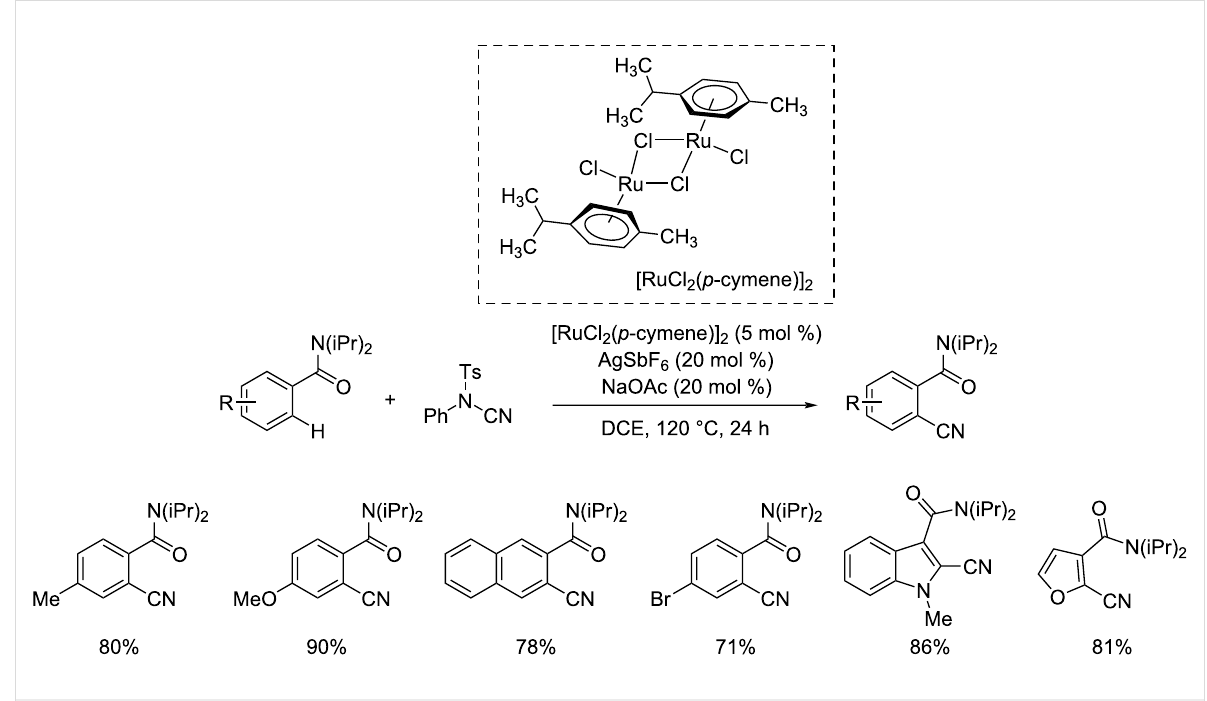
Scheme 13: Cyanation of arenes and heteroarenes using a ruthenium(II) catalyst and N -cyano- N -phenyl- p -toluenesulfonamide (NCTS) as cyanating